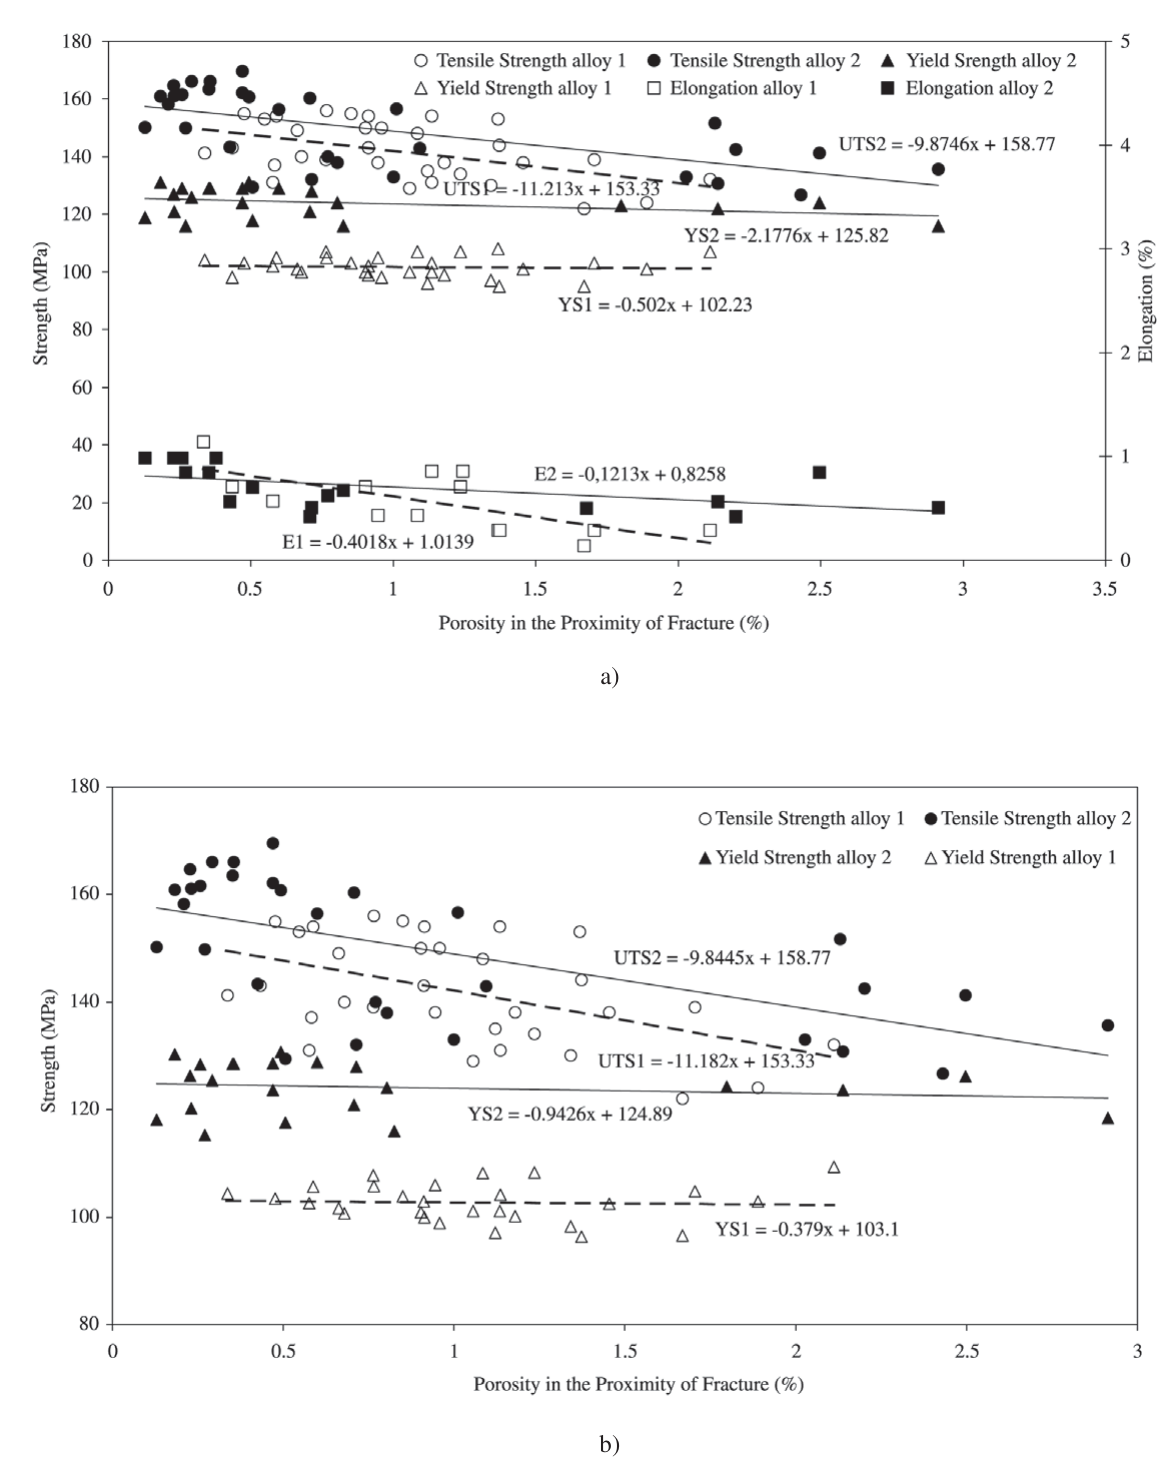
Figure 6. a)Tensile strength, yield strength and elongation rate as a function of the volumetric porosity near the fracture surface of the two alloys; b) Tensile strength and yield strength as a function of the volumetric porosity near the fracture surface of the two alloys. Rm is the tensile strength corrected by a factor of 1.5. Ry is the yield strength corrected by the area of pores.